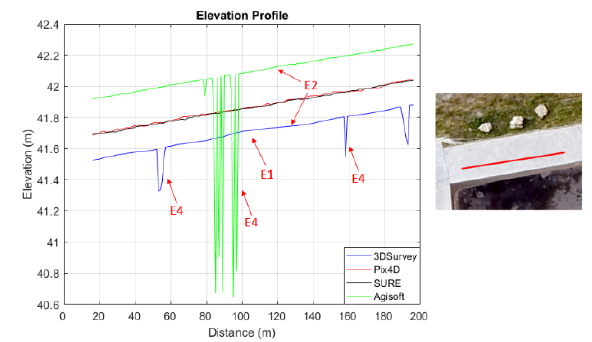
Figure 4. Elevation profiles on DSMs at sloped flat surface